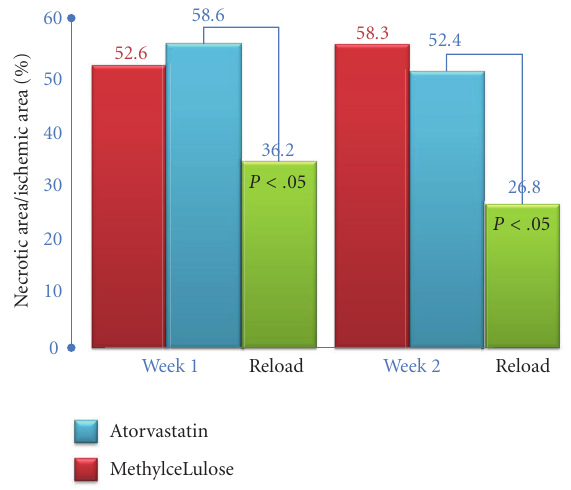
Figure 4: Statins and recapture of the RISK pathway. This modified graphic of Mensah’s work, shows how the quotient (necrosis/ischemia) is similar in rats treated for 1 or 2 weeks with methylcellulose (red bars) or atorvastatin (blue bars). This loss of myocyte-protective e ff ect is “recaptured” significantly with the reload of atorvastatin (green